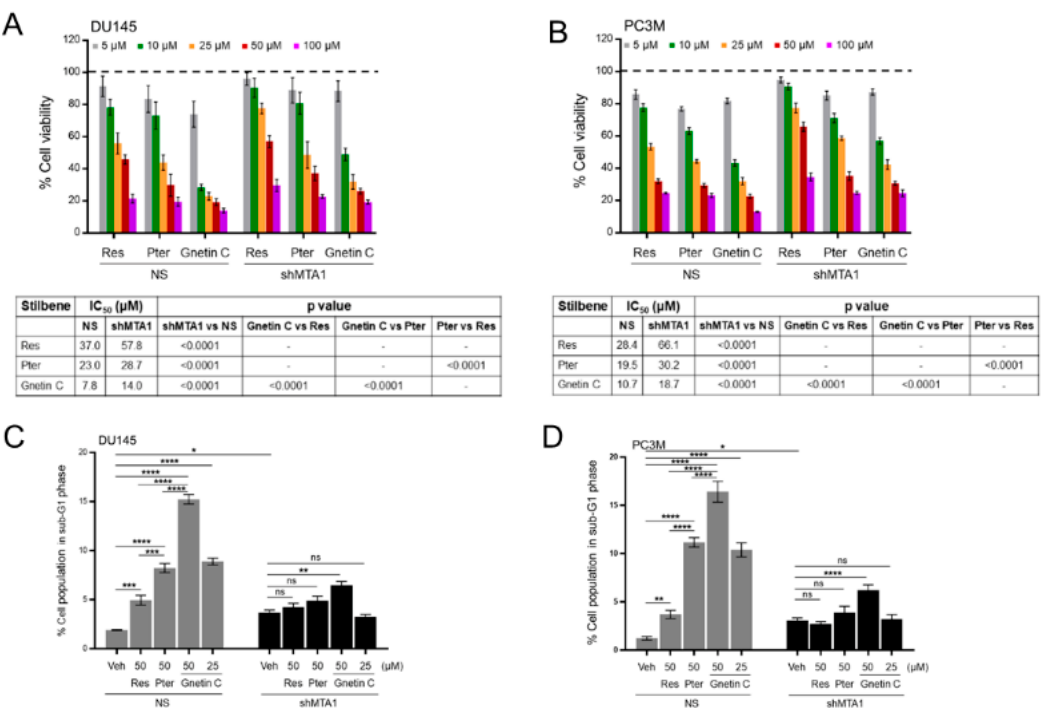
Figure 2. Gnetin C induces MTA1-dependent cytotoxicity in PCa cells more potently than resveratrol and pterostilbene. ( A , B ) Cell viability analysis of DU145 and PC3M cells treated with various concentrations (5–100 μ M) of Res, Pter, and Gnetin C. Bottom , IC 50 quantifications from the cell viability analysis. ( C , D ) Cell cycle analysis of DU145 and PC3M cells showing percentage of cell death after treatment with Res (50 μ M), Pter (50 μ M), and Gnetin C (25, 50 μ M). Data represent the mean ± SEM of three independent experiments. * p < 0.05; ** p < 0.01; *** p < 0.001; **** p < 0.0001 (one-way ANOVA).